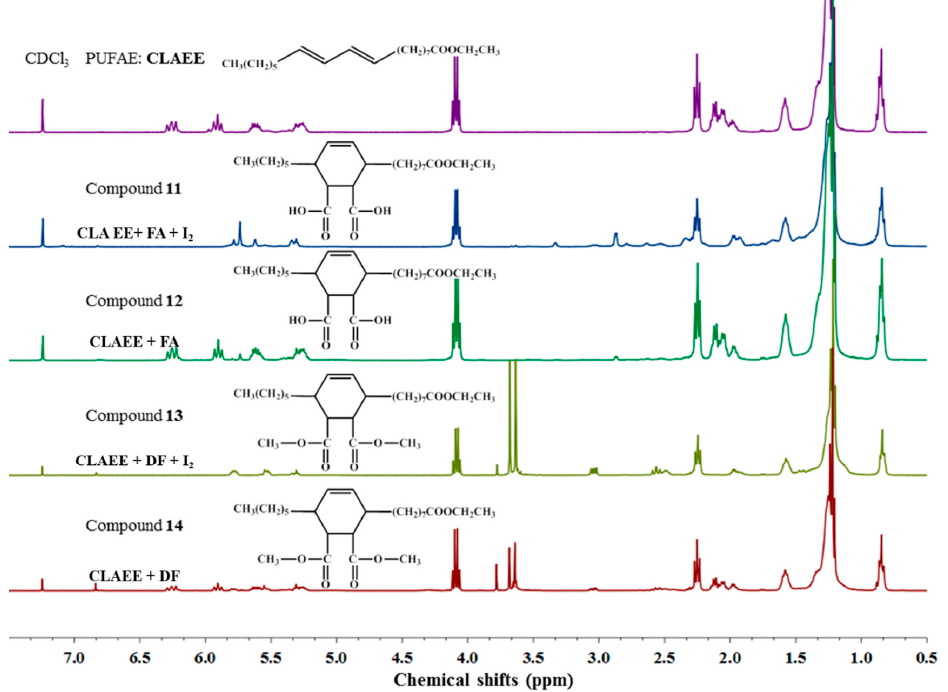
Figure 4. 1 H-NMR spectrum of conjugated linoleic acid ethyl ester (CLAEE) and the reaction compounds with dienophiles in chloroform-d under different catalyst conditions: compound 11 , reaction products of CLAEE and FA with iodine catalysis; compound 12 , reaction products of CLAEE and FA without iodine catalysis; compound 13 , reaction products of CLAEE and DF with iodine catalysis; compound 14 , reaction products of CLAEE and DF without iodine catalysis. Both compound 11 and compound 12 were obtained as 22-carbon tricarboxylic acid monoethyl ester (C22TAMEE). Its molecular formula C 24 H 40 O 6 was established from ESI-MS: compound 11 , m/z